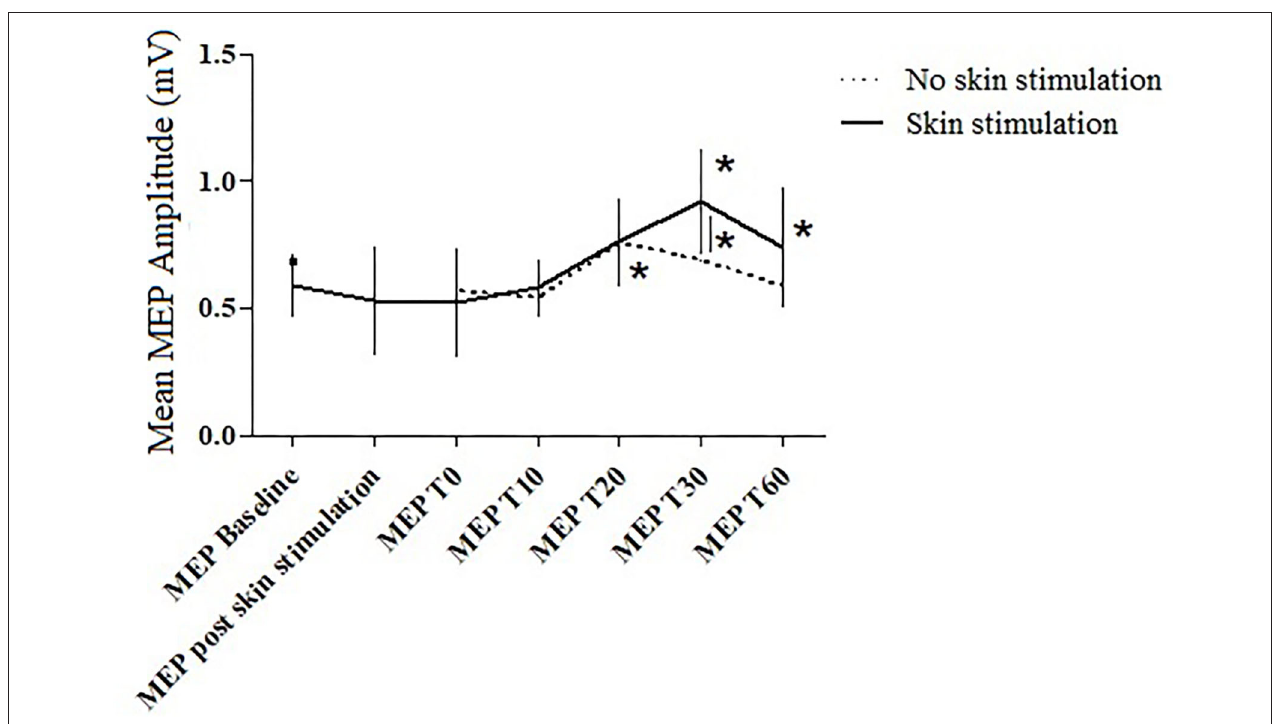
FIGURE 3 | The MEP amplitude in the two trials at the different time points. Error bars indicate the SEM. * = p < 0.05.